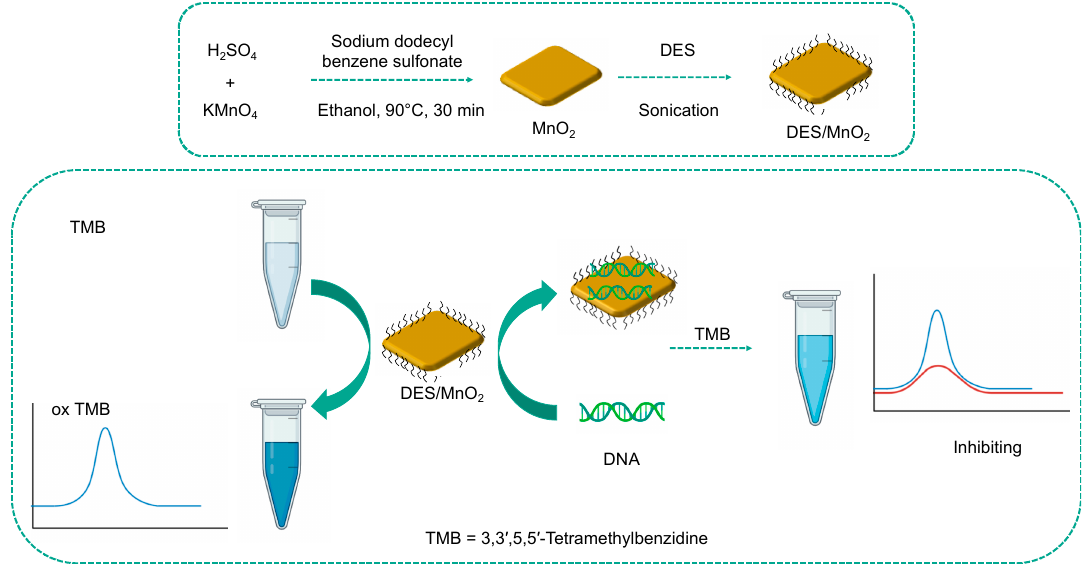
Figure 10. Preparation of DES/MnO 2 and its application for the colorimetric detection of DNA. Adapted with permission from [70].